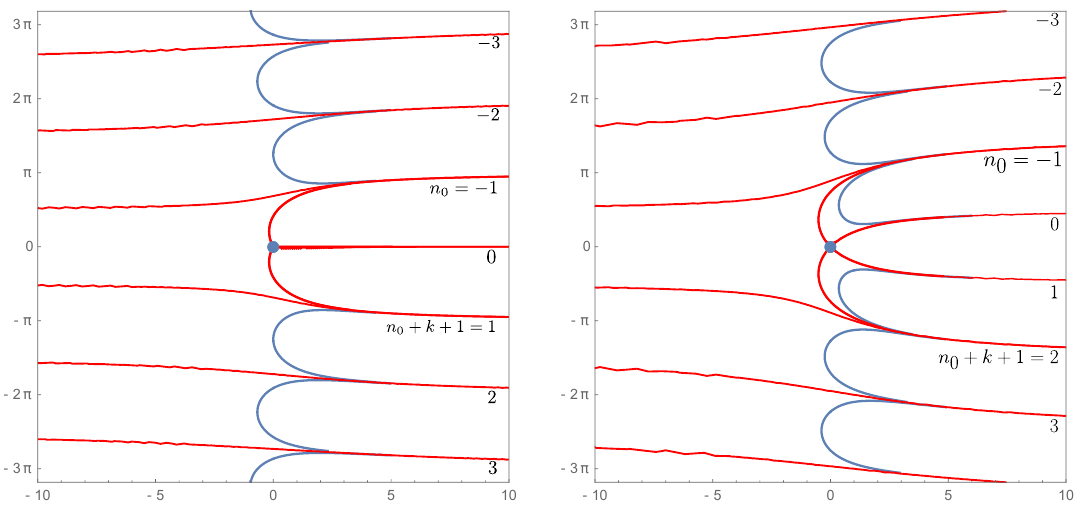
Figure 4 . WKB diagram for k = 1 (left) and k = 2 (right). Generic flow lines and WKB lines are colored blue and red respectively. θ is chosen to be 0 and − i π respectively. We number the WKB 2 lines on large positve x side increasingly from top. There are k + 2 WKB lines that are connected to the zero, numbered from n to n + k + 1 0 0